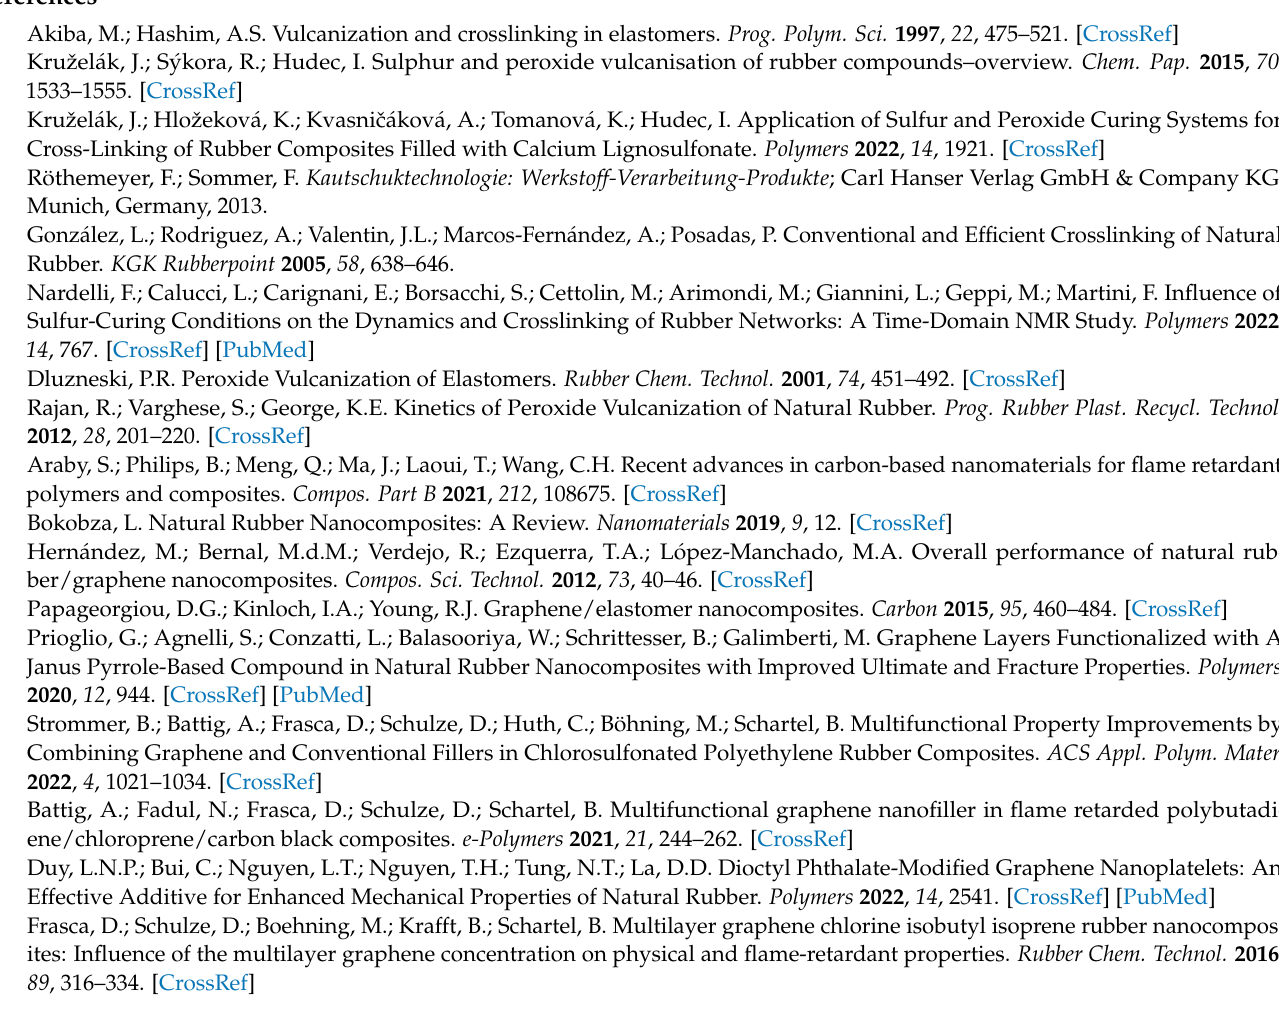
the square root of time, Table S1: Recipes of nanocomposites, Table S2: mixing protocols, Table S3: results of DSC measurements, Table S4: results of MDR measurements, Table S5: results of swelling and density measurements, and parameters for the determination of the crosslinking density according to Flory–Rehner, Table S6: results of Shore A hardness measurements, Equations (S1) and (S2): additional information on the calculation of the crosslinking